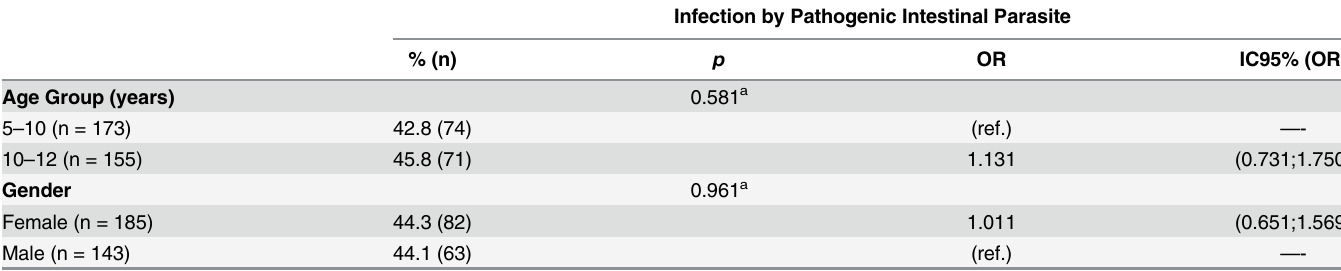
Table 3. Binary regression for infection by pathogenic intestinal